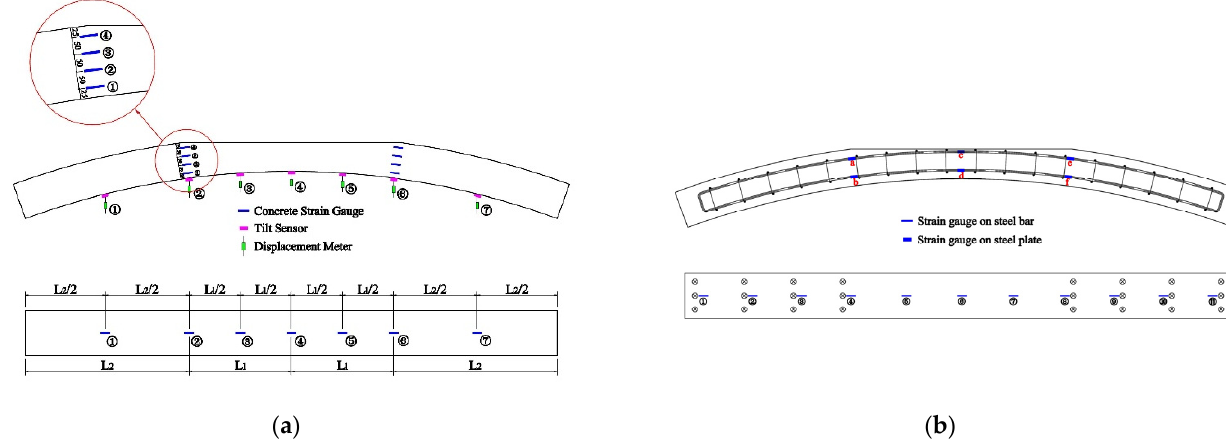
Figure 7. Measurement scheme. ( a ) Measurement scheme of the concrete; ( b ) Measurement scheme of the reinforcement.